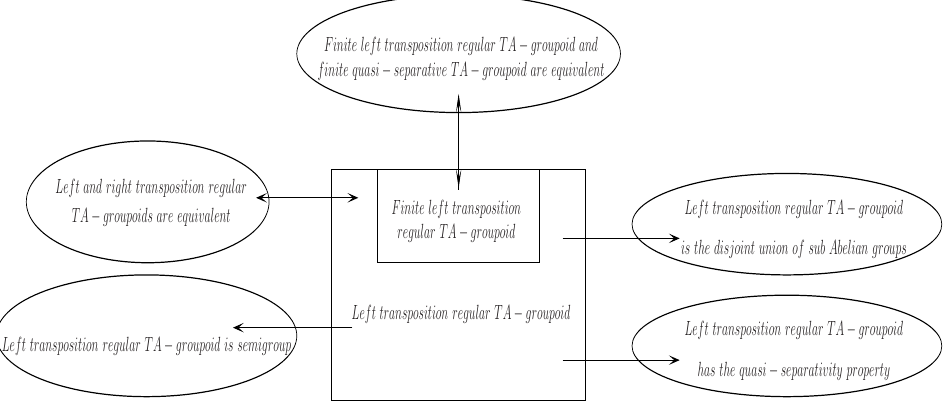
Figure 4. The main results of the TA-groupoids obtained in this